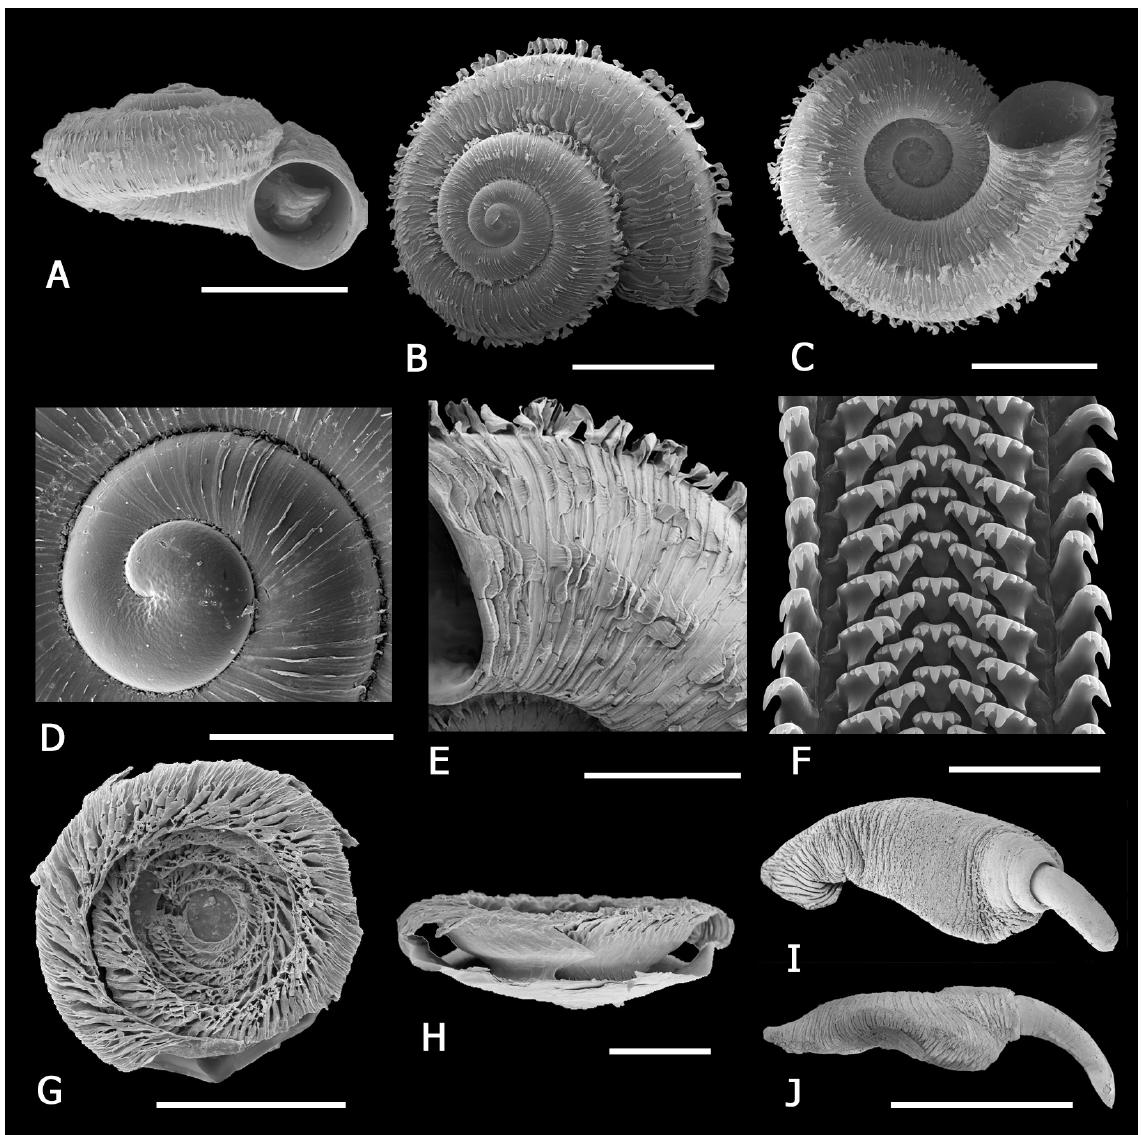
Fig. 24. Chondrocyclus cooperae sp. nov. A . Aperture view (ELM W3620/T136). B . Dorsal view (ELM W3620/T136). C . Ventral view (ELM W3620/T136). D . Protoconch (ELM W3620/T136). E . Detail of axial lamellae of periostracum (ELM W3620/T136). F . Portion of radula (ELM W3623/T121). G–H . Operculum (ELM W3623/T121). I . Penis, dorsal view (ELM W3623/T121). J . Penis, lateral view (ELM W3212/T140). Scale bars: A–C = 2 mm; D, H = 500 µm; E, G, I–J = 1 mm; F = 50